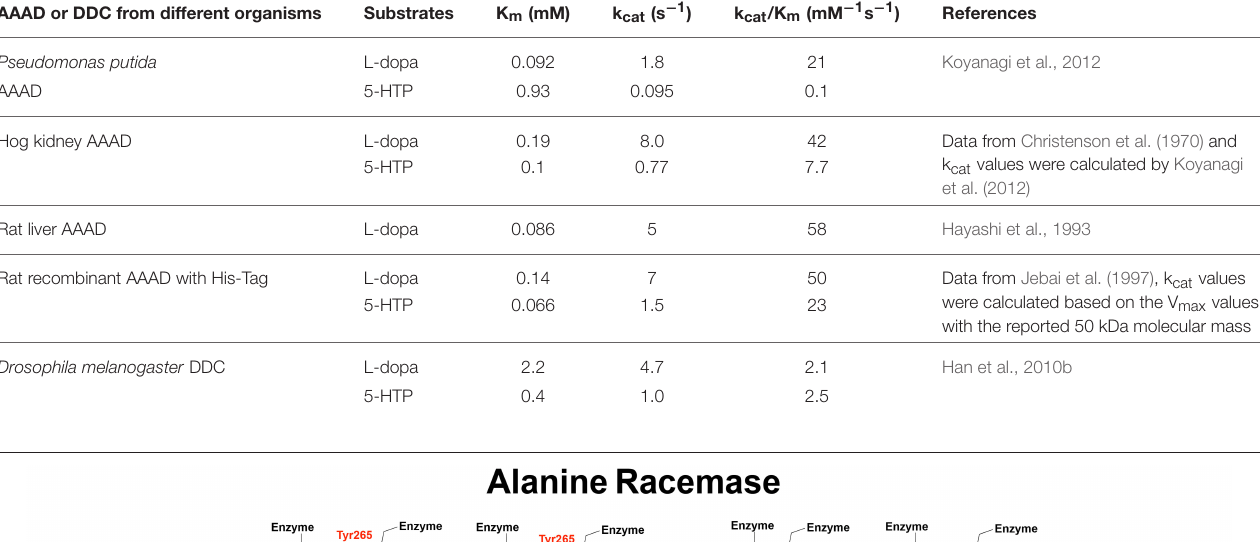
TABLE 1 | Kinetic parameters of Pseudomonas putida and mammalian aromatic amino acid decarboxylases (AAAD) and insect 3,4-dihydroxyphenylalanine decarboxylase (DDC) for the two natural substrates L-3,4-dihydroxyphenylalanine (L-dopa) and 5-hydroxytryptophan (5-HTP). AAAD or DDC from different organisms